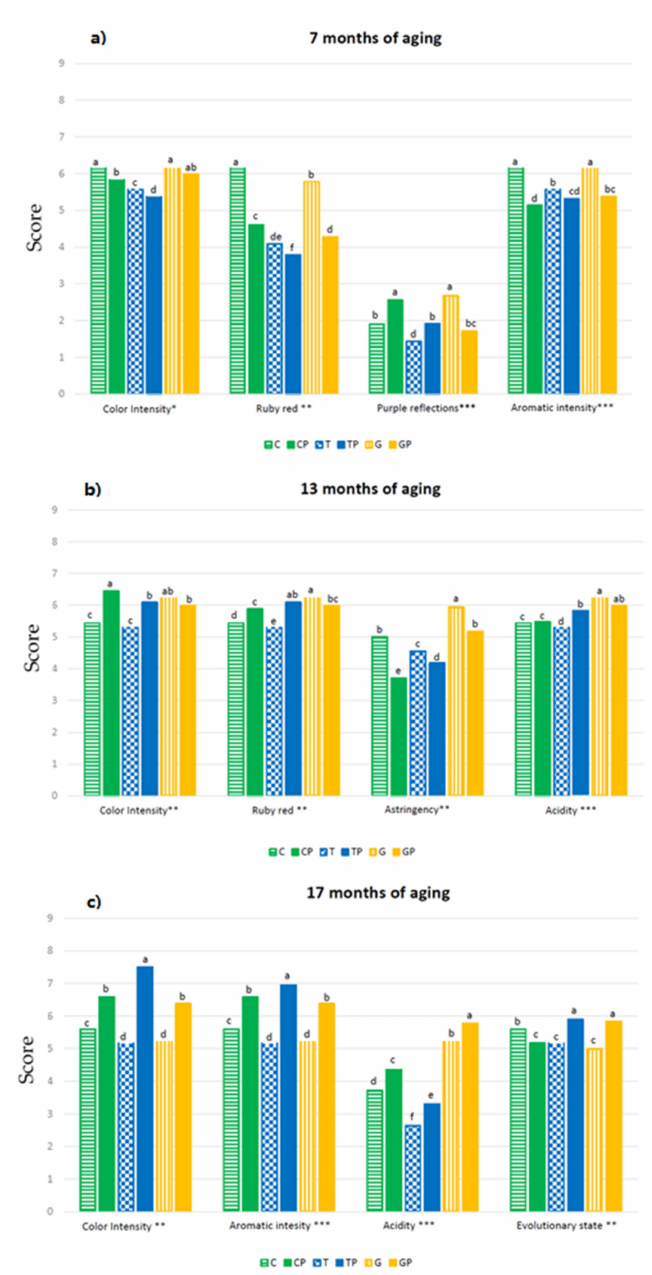
Figure 7. Significant quantitative parameters of wines after: ( a ) 7 months of aging (May 2020), ( b ) 13 months of aging (November 2020), and ( c ) 17 months of aging (March 2021). The evaluation was carried out using a score (0–10). Different letters indicate statistically significant differences at p ≤ 0.05 according to the results of two-way ANOVA. Significance level *** p < 0.001, ** p < 0.01; * p ≤